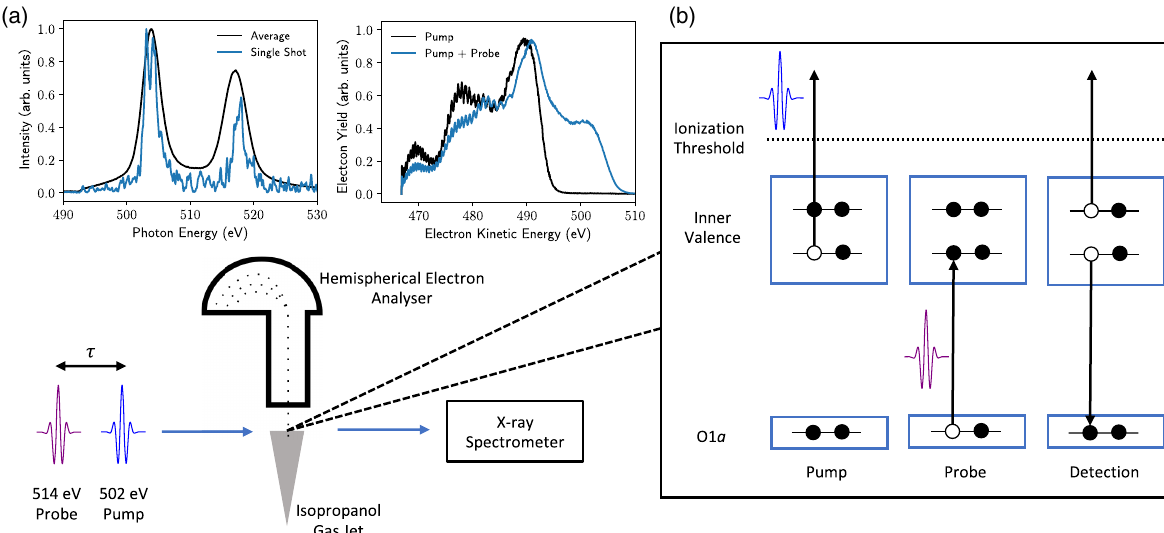
FIG. 2. (a) Experimental setup with two color pulses (pump central photon 502 eV, probe central photon energy 514 eV) from the fresh slice mode with delay controlled by chicane, the interaction point equipped with a hemispherical electron analyzer and a downstream x-ray spectrometer to determine the pulse spectra and relative energies on every shot. (b) Pump step opens a number of valence ionization channels including creation of inner valence holes (IVH). The delayed probe pulse can strongly interact via a O 1 a → IVH transition (a channel only open if inner valence ionization has occurred). Following this there can be Auger-Meitner decay back to the O 1 a hole with the emission of Auger-Meitner electrons of characteristic energy that can be